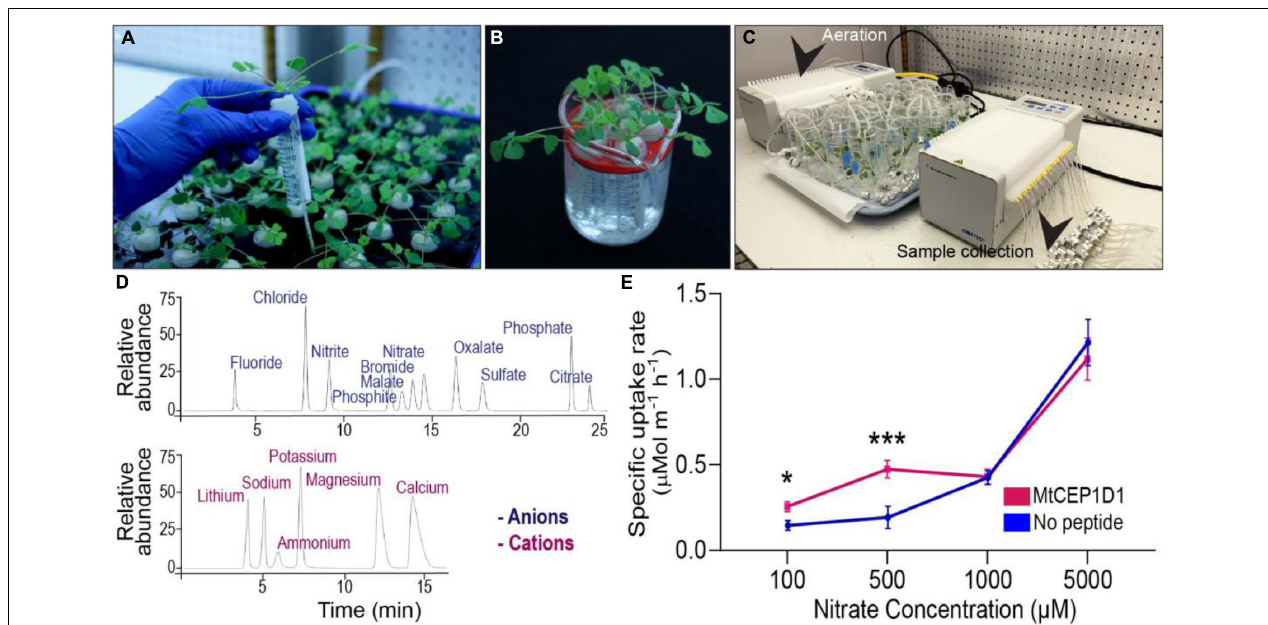
FIGURE 1 | A phenotyping platform for determining uptake rates of multiple ions simultaneously. (A) Medicago truncatula plants grown in aerated hydroponic tanks for 11 days. (B) Treatment of plants in nutrient deprivation solution for 48 h with 1 µ M added peptide of interest. (C) Nutrient uptake assay consisting of 24 hydroponic chambers with one plant each. (D) Determination of nutrient concentrations in collected samples by ion chromatography. Time of elution determined for 11 cations and 6 anions using known standard solutions. (E) Enhanced specific nitrate uptake rate in the high-affinity range (100–500 µ M) resulting from pre-treatment with 100 nM MtCEP1D1 Student’s t -test * p < 0.05, *** p < 0.001. n = 4–6 per